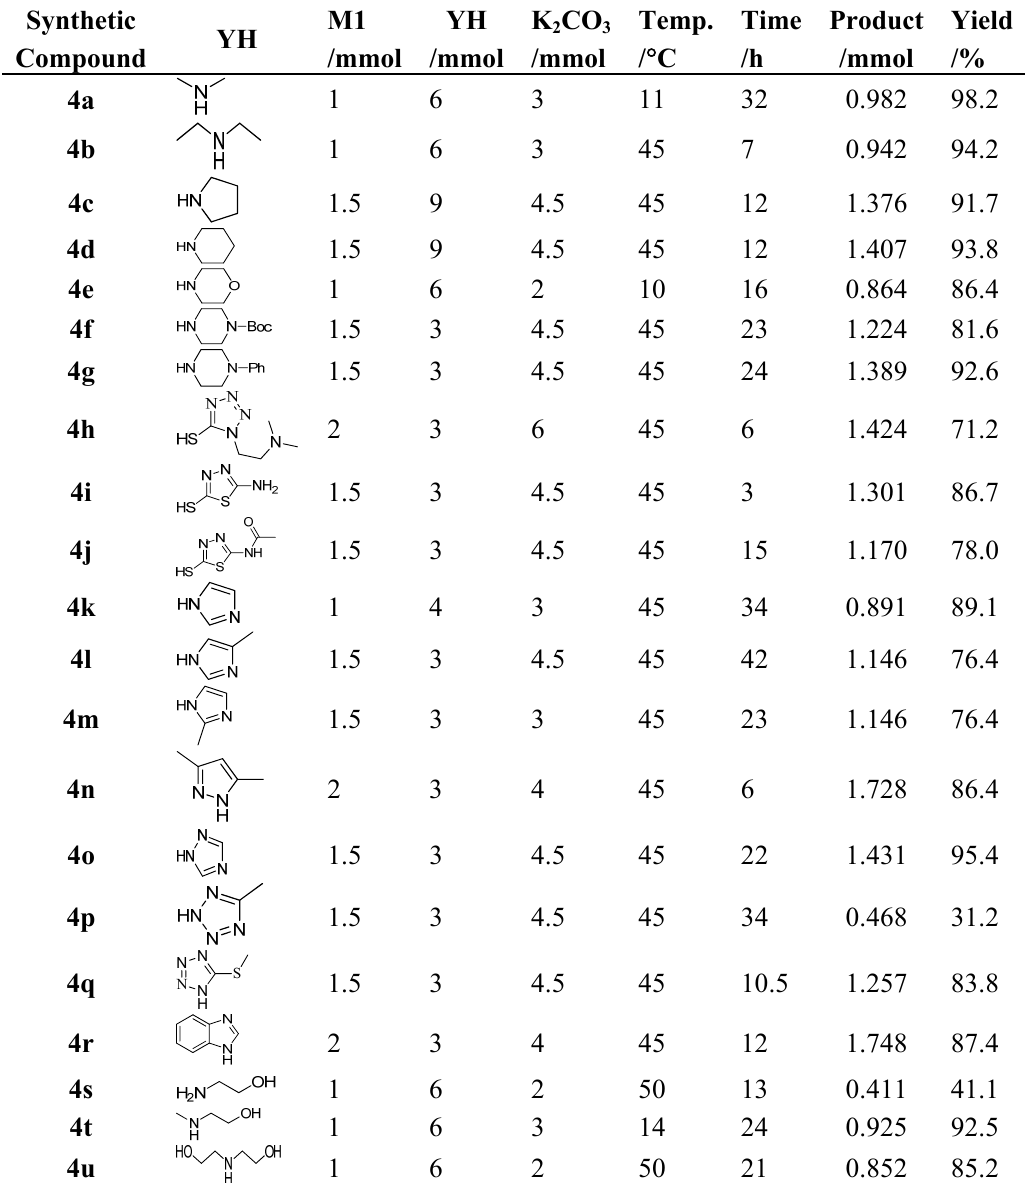
Table 3. Experimental results of target compounds 4a – u